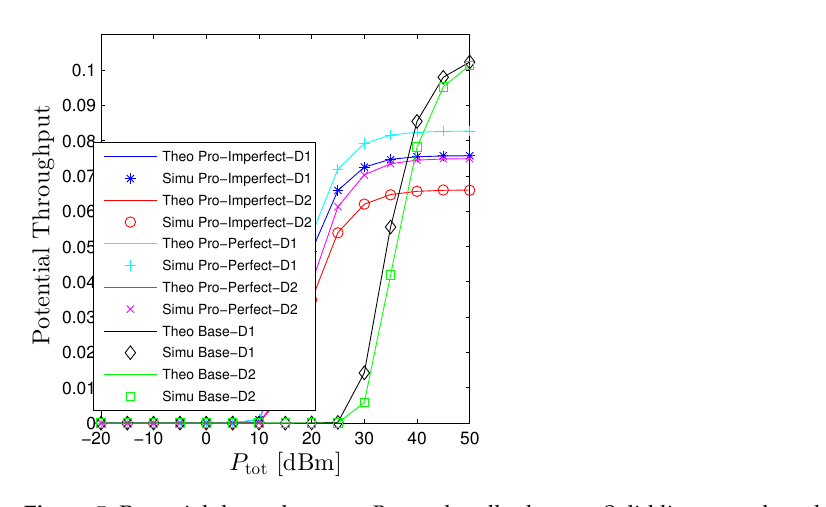
Figure 5. Potential throughput vs. P tot under all schemes. Solid lines are plotted by employing (13) while markers are Monte Carlo